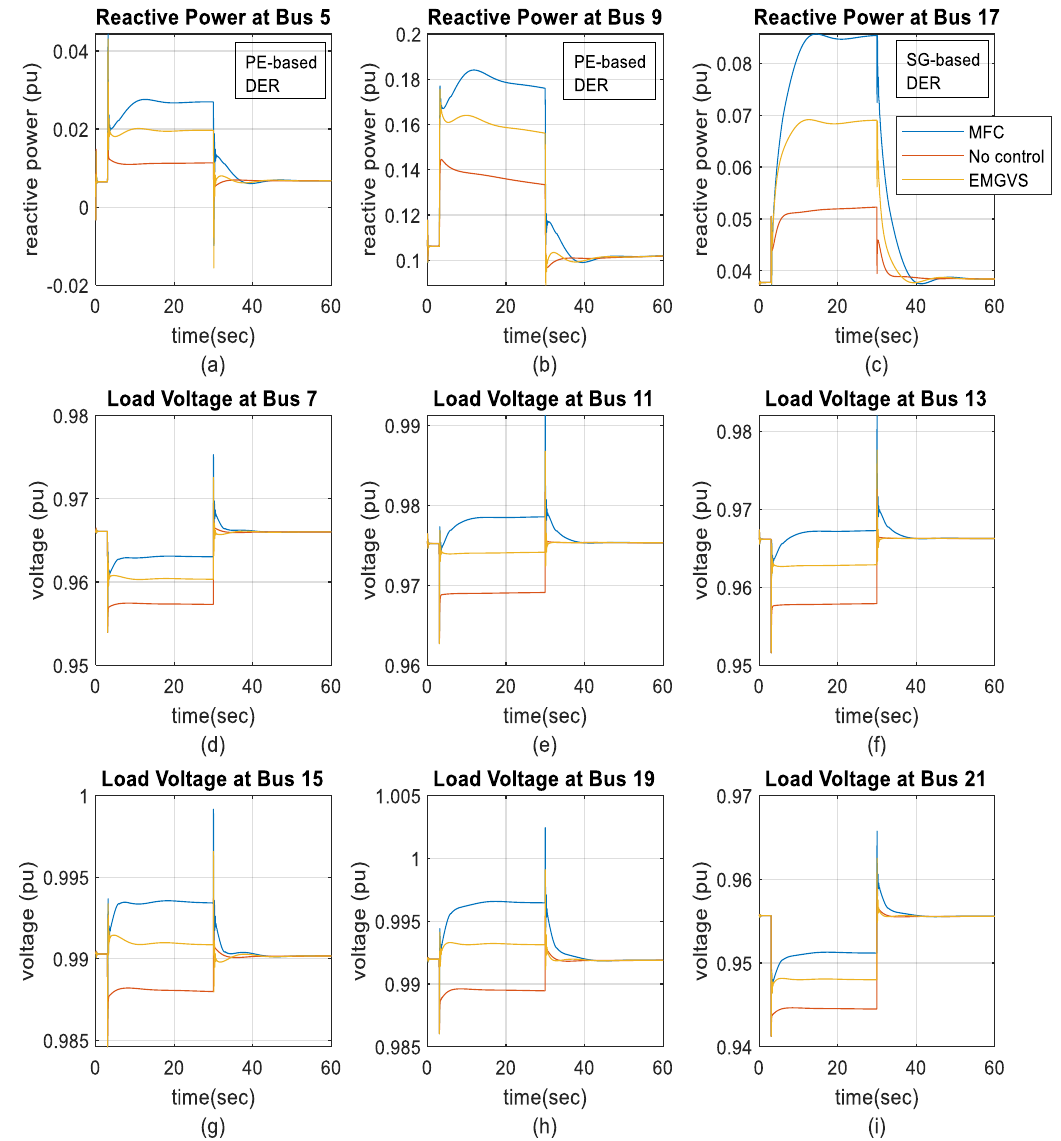
Figure 14. Simulation results for the IEEE 21-bus microgrid system with two PE-based DERs and one SG-based DER under a 25% load increase at all load buses ( Case 1 )—( a ) reactive power at bus 5; ( b ) reactive power at bus 9; ( c ) reactive power at bus 17; ( d ) load voltage at bus 7; ( e ) load voltage at bus 11; ( f ) load voltage at bus 13; ( g ) load voltage at bus 15; ( h ) load voltage at bus 19; ( i ) load voltage at bus 21.